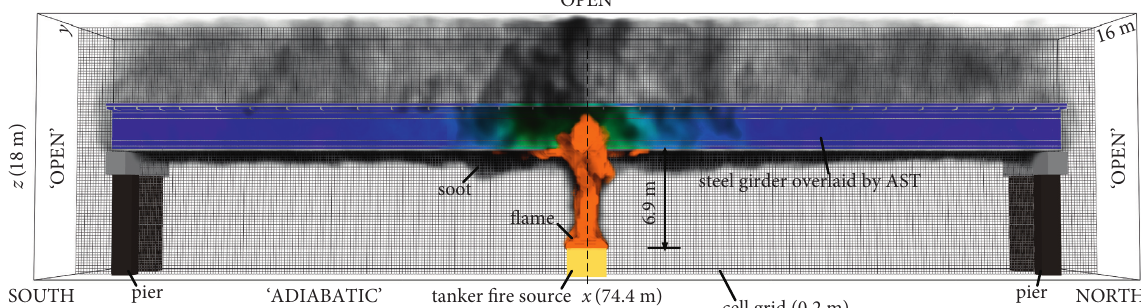
Figure 4: FDS model and fire